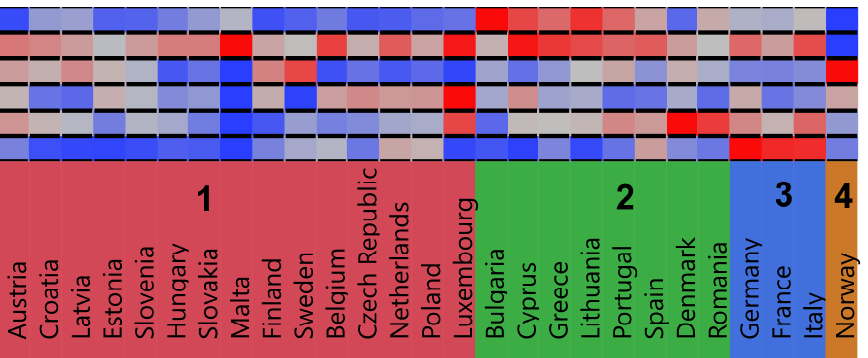
indicators also depend on technical solutions, structure of industries, states’ own resources of energy raw materials, and other factors.